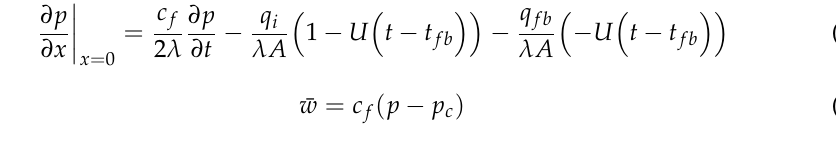
Table 1. Fracture compliance expressions for different fracture geometry models. Fracture Geometry PKN KGD Radial c